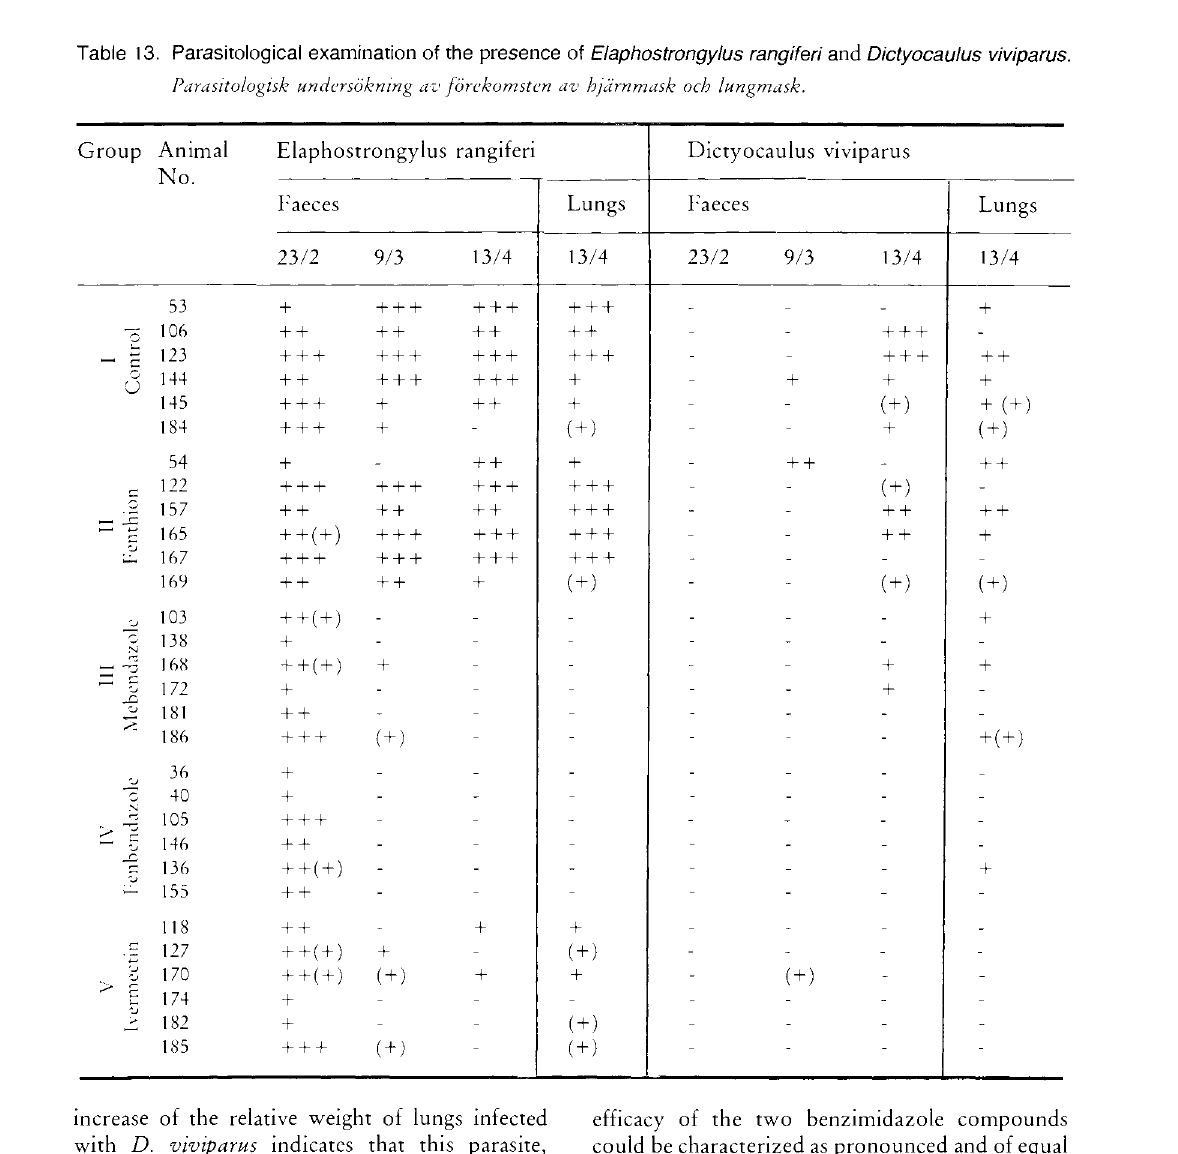
Table 13. Parasitological examination of the presence of Elaphostrongylus rangiferi and Dictyocaulus viviparus.